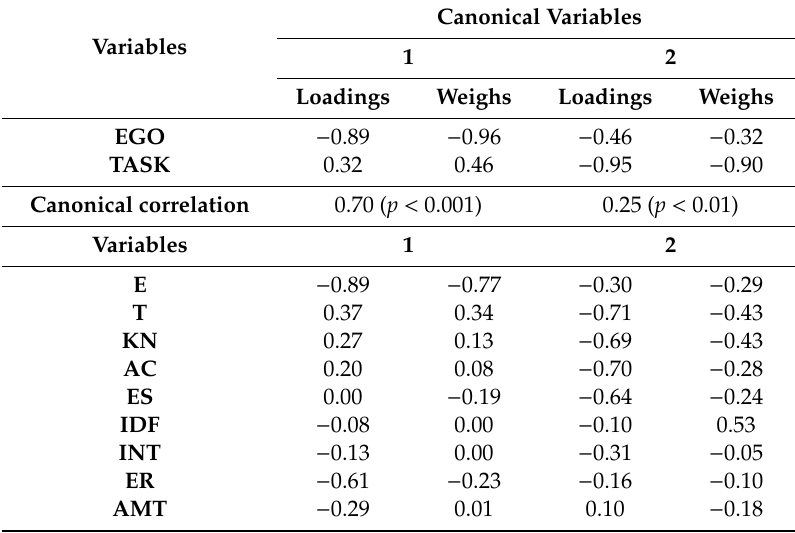
Table 4. Characteristics of canonical